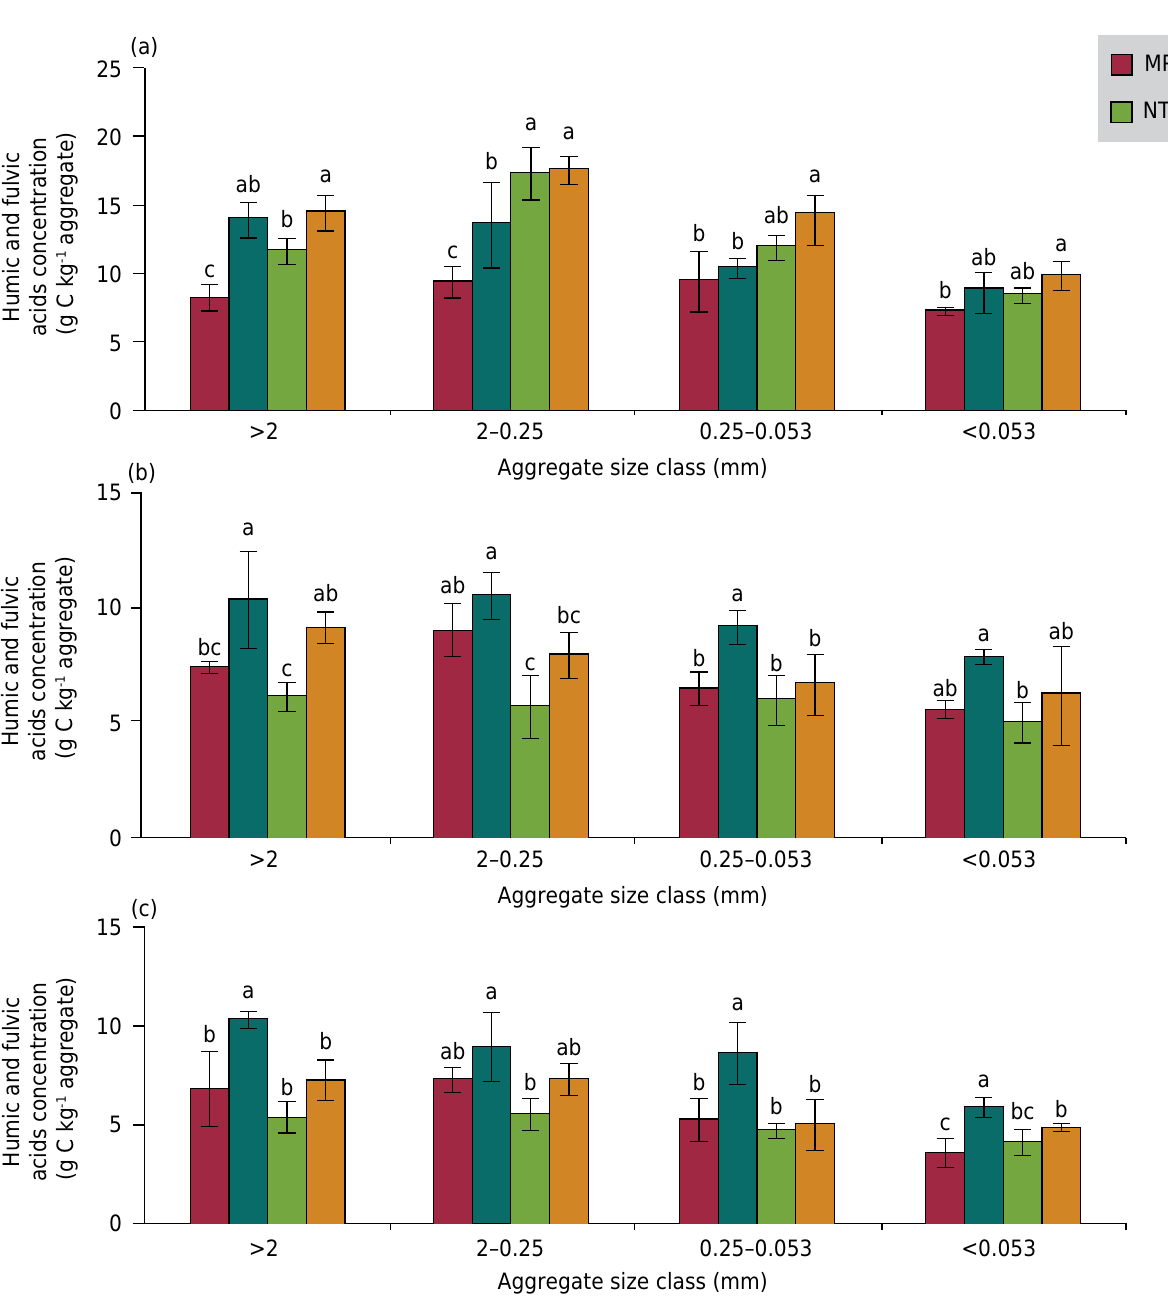
Figure 3. Humic and fulvic acids concentration in varied aggregate size fractions in different soil layers as influenced by tillage treatments.(a) 0.00-0.05 m; (b) 0.05-0.20 m; (c) 0.20-0.30 m. MP-S: moldboard plow without straw; MP+S: moldboard plow with straw; NT-S: no-tillage without straw; NT+S: no-tillage with straw. Error bars represent standard errors of the means (n = 3). Different lower-case letters within an aggregate size indicate significant differences between treatments according to Duncan’s test